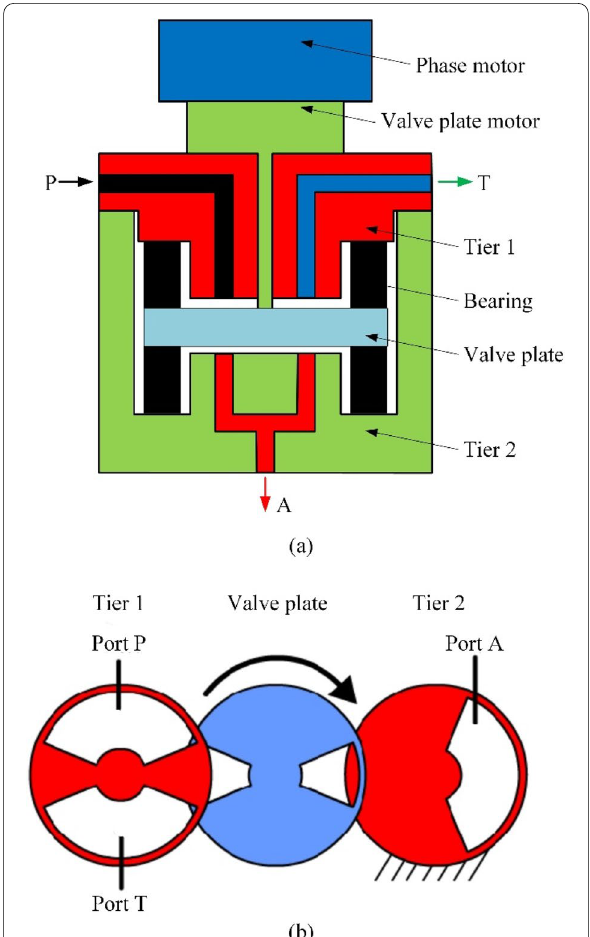
Figure 4 Disc-style rotary valve proposed by Katz: a schematic of the valve, b disc architecture